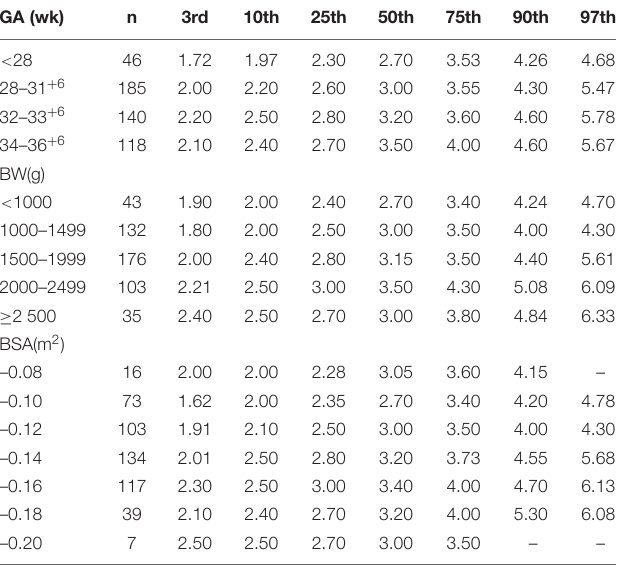
IVSd, end-diastolic interventricular septum.